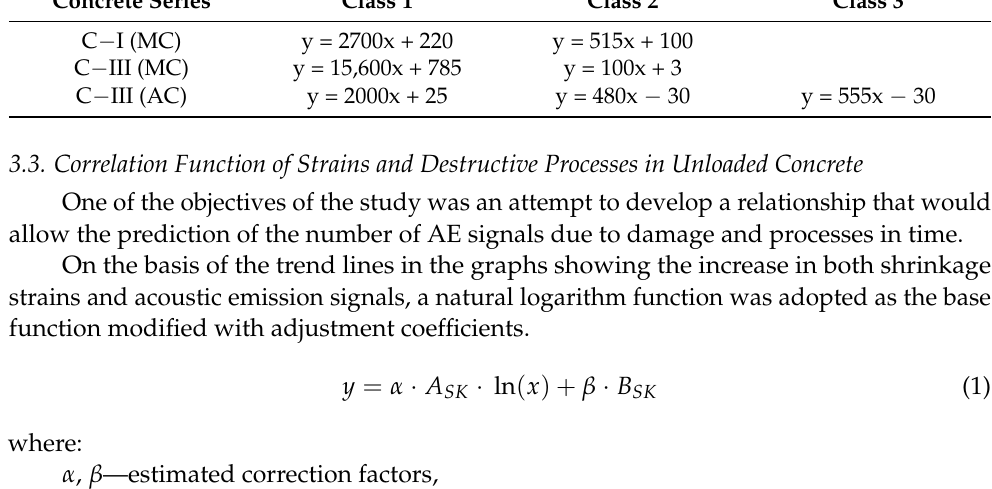
Table 5. Equations of linear functions of the correlation between strains and energy of AE signals. Concrete